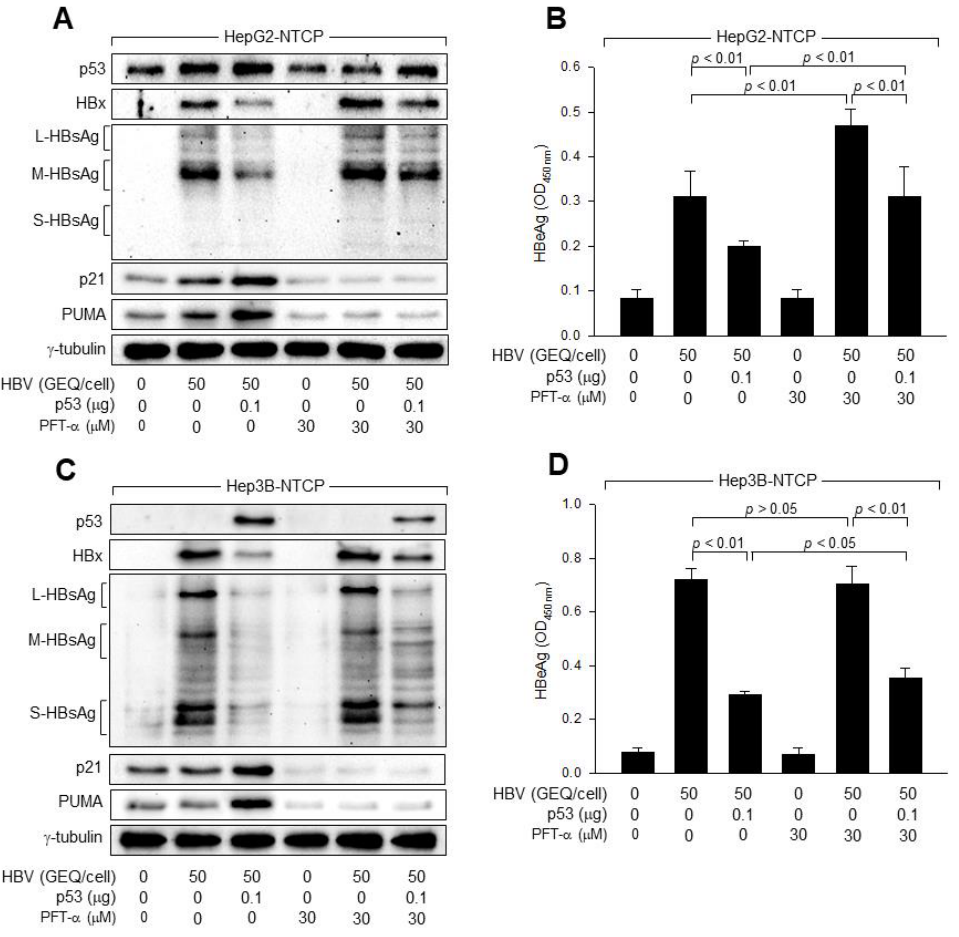
Figure 3. p53 transcriptional activity is not essential for inhibition of HBV replication. ( A , B ) HepG2- NTCP and Hep3B-NTCP cells were transfected with either an empty vector or p53 expression plasmid for 24 h and either mock-infected or infected with HBV at 50 GEQ/cell for 4 days in the presence or absence of pifithrin-alpha (PFT- α ), followed by Western blotting. ( B ) Levels of HBeAg released from the cells prepared in ( A ) were measured by ELISA ( n = 4). ( D ) The levels of HBeAg released from the cells prepared in ( C ) were measured by ELISA ( n = 5).